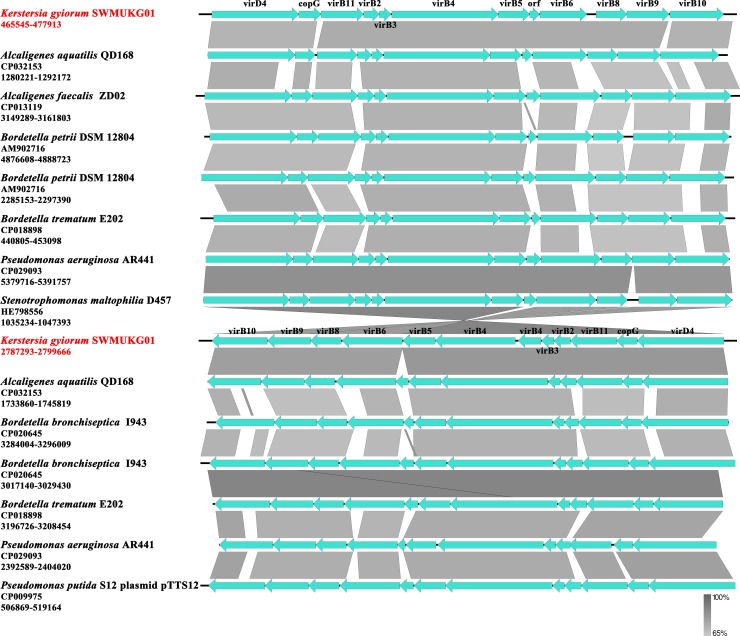
Structure and distribution of T4SS in K. gyiorum SWMUKG01 and other related bacteria.The box arrows represent ORFs. Similar regions are indicated with the degree of nucleotide identity being shown in gray scales.